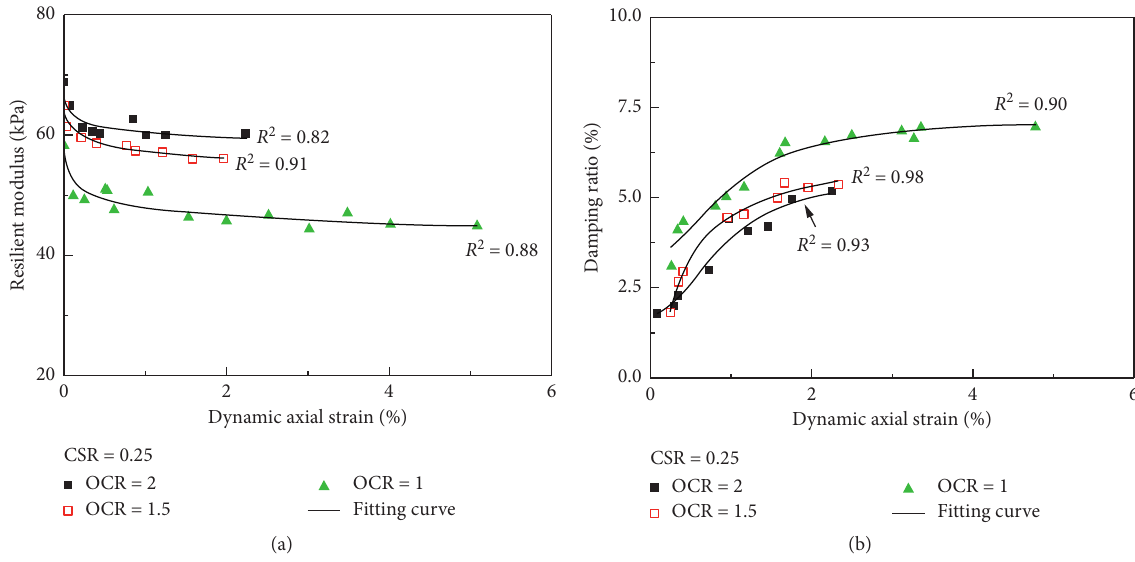
Figure 8: Variations of dynamic parameters with dynamic axial strain at different OCR: (a) M